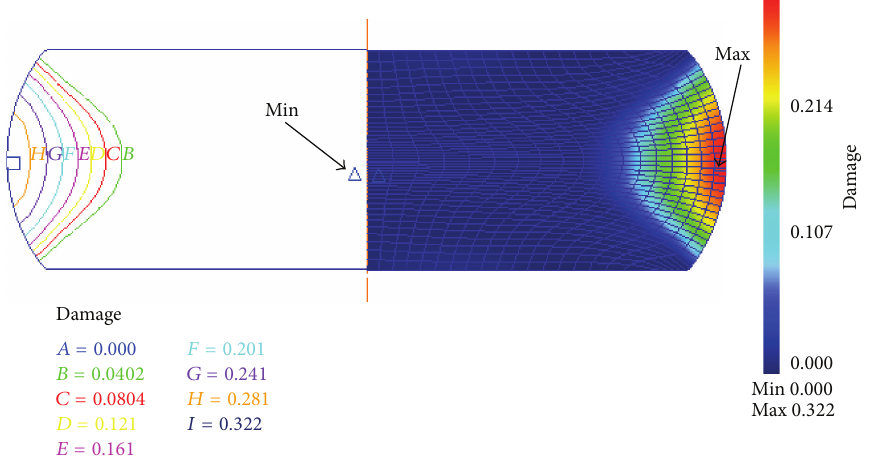
Figure 4: The damage distribution of the height reduction of 60% at temperature 1348 K and strain rate 0.01 s −1 .